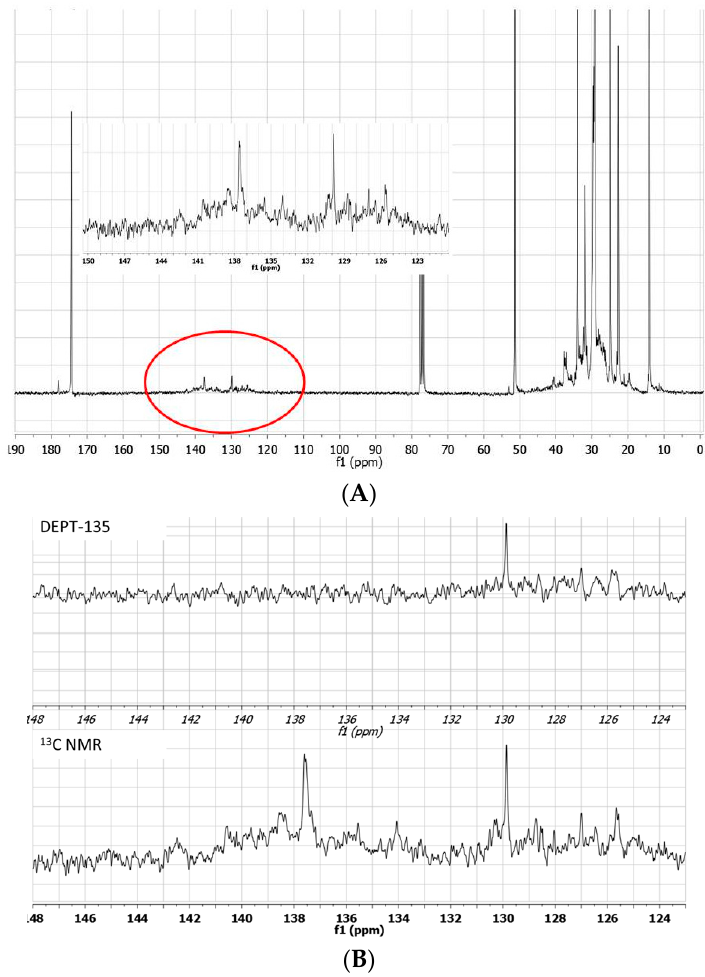
Figure 4. 13 C-NMR spectrum of the blank experiment carried out in [bmim][GaCl 4 /Ga 2 Cl 7 ] in the absence of propene. Insert shows the region circled in the spectrum ( A ). 13 C-NMR and DEPT-135 expanded spectra of the region between 148–123 ppm ( B ).